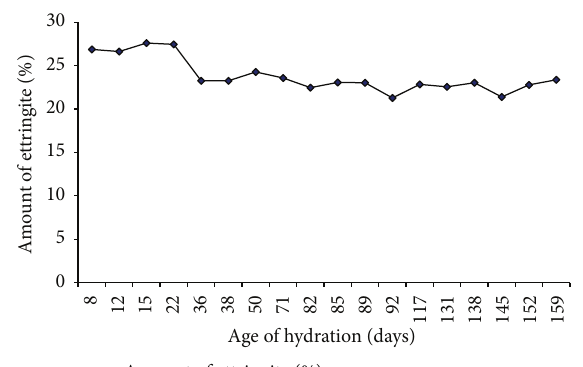
Figure 6: Average amount of ettringite in hydrated ye’elimite clinker exposed to laboratory conditions.